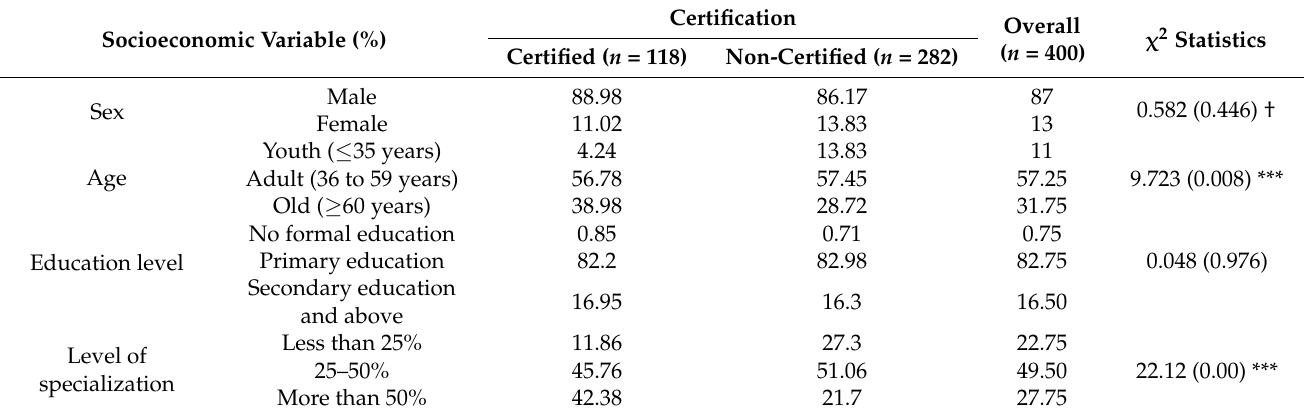
Table 2. Socioeconomic characteristics of coffee farmers involved in the